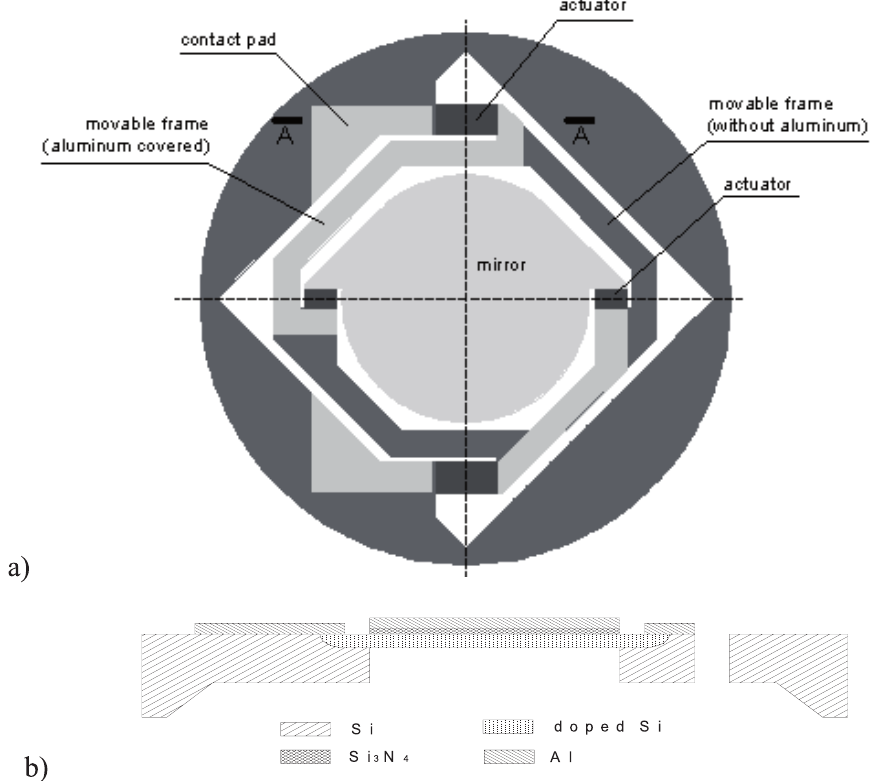
Fig. 2. Proposed microscanner a) planar projection, b) cross-section A-A through the frame and the scanning actuators; materials and layers thickness: Si (frame and mirror) – 15 μ m, doped Si (passive layer) – 1 μ m, silicon nitride (insulator) – 0.15 μ m, Al (active layer) – 0.7 μ